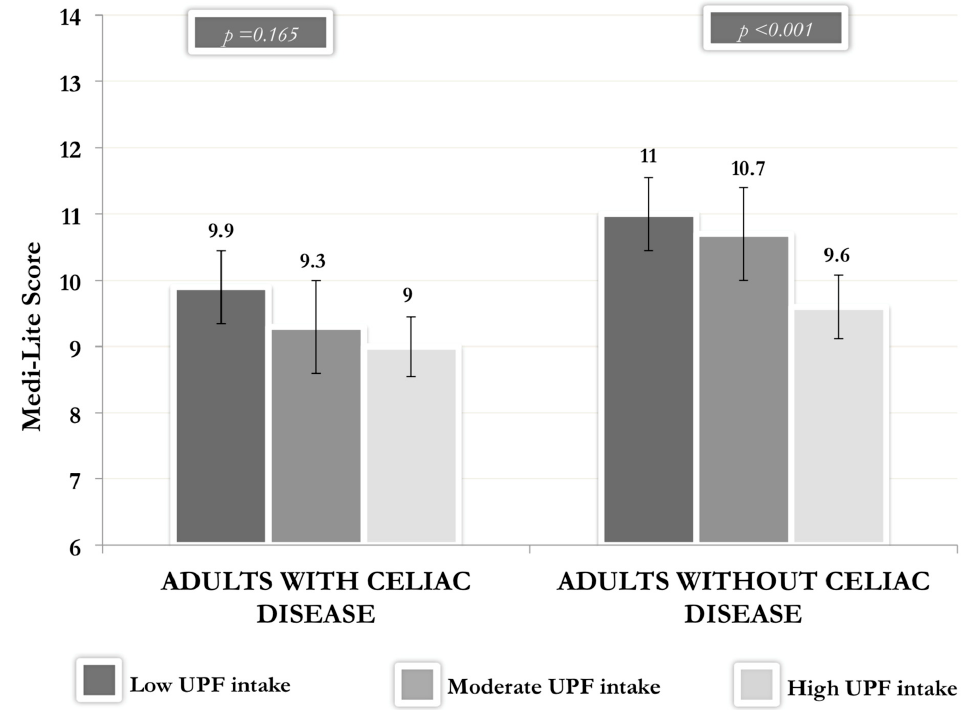
Figure 2. Medi-Lite Score according to the level of UPF consumption in adults with and without celiac disease. Legend: UPF: ultra-processed foods. Vertical bars represent the 95% confidence interval (CI).